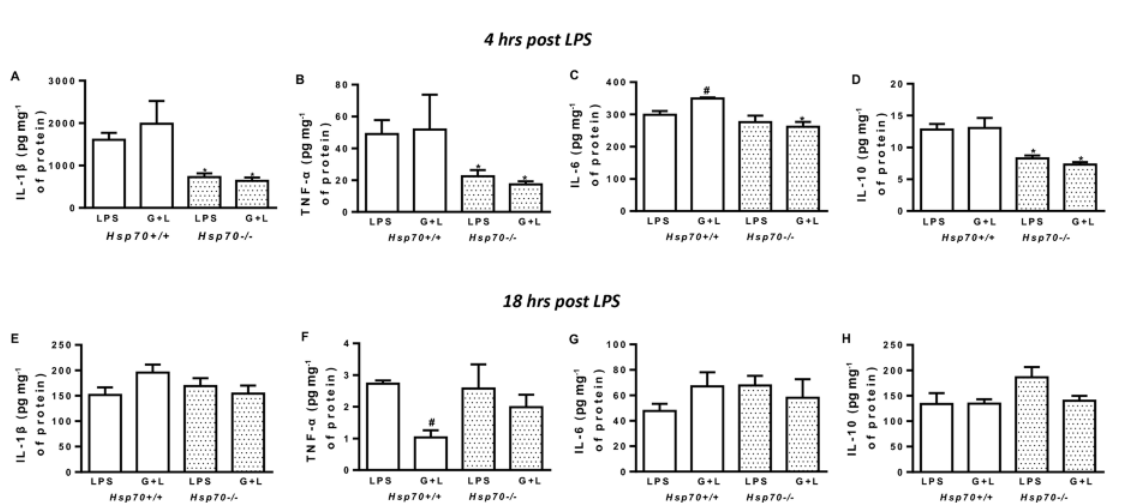
Figure 2. E ff ect of LPS and GLN on lung cytokine secretion in Hsp70+/+ and Hsp70-/- mice. ELISA analysis of lung tissues of IL-1 β , TNF- α , IL-6 and IL-10 at 4 hrs (A-D) and at 18 hrs (E-H) post LPS administration respectively. All mice received, i.p., GLN (0.75 mg/kg) or normal saline and one hour later LPS (150 μ g). Results are presented as means ± SEM. Asterisks (*) depict statistical di ff erence between genotypes exposed to the same treatment. *, p < 0.05; **, p < 0.001; ***, p < 0.0001. Hash signs (#) depict statistical di ff erence between treatments on the same genotype. #, p < 0.05. Each graph shows a representative experiment of at least three independent